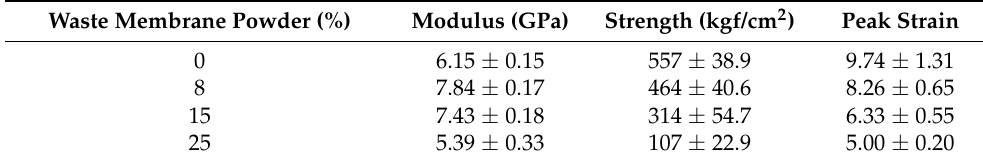
Table 4. Powder-containing mortar compression test results.